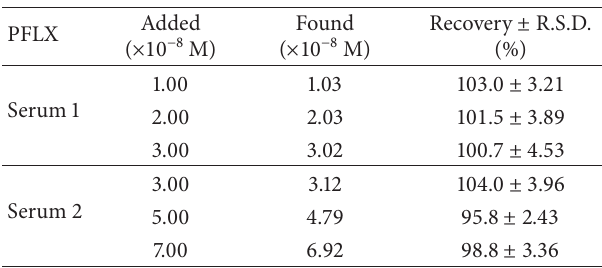
Table 4: Analytical recoveries of PFLX in serum samples ( 𝑛 = 5